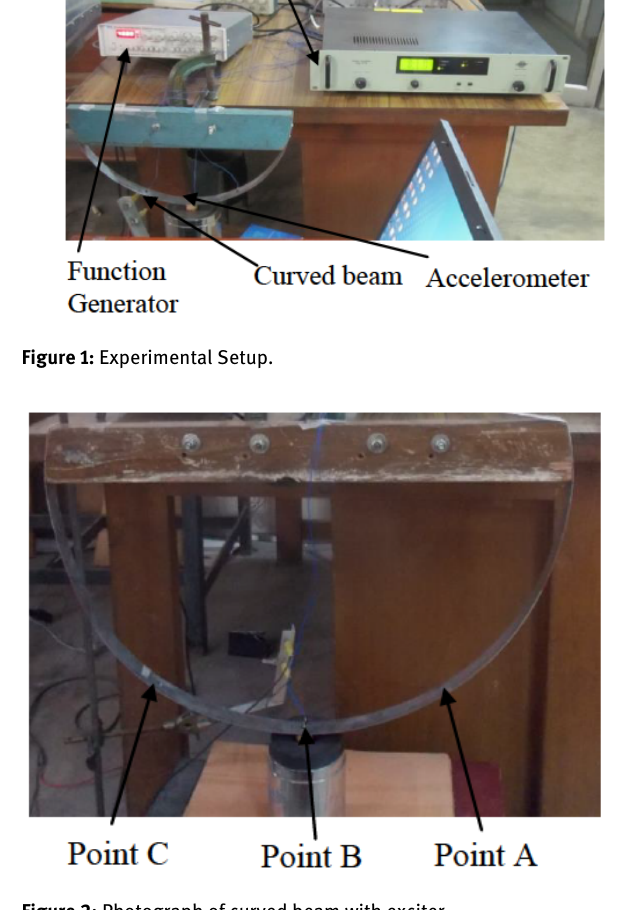
sured along the curved length of the beam from left end. The LMS SCADAS III and LMS test lab software are used for data acquisition and signal processing. Beams are excited